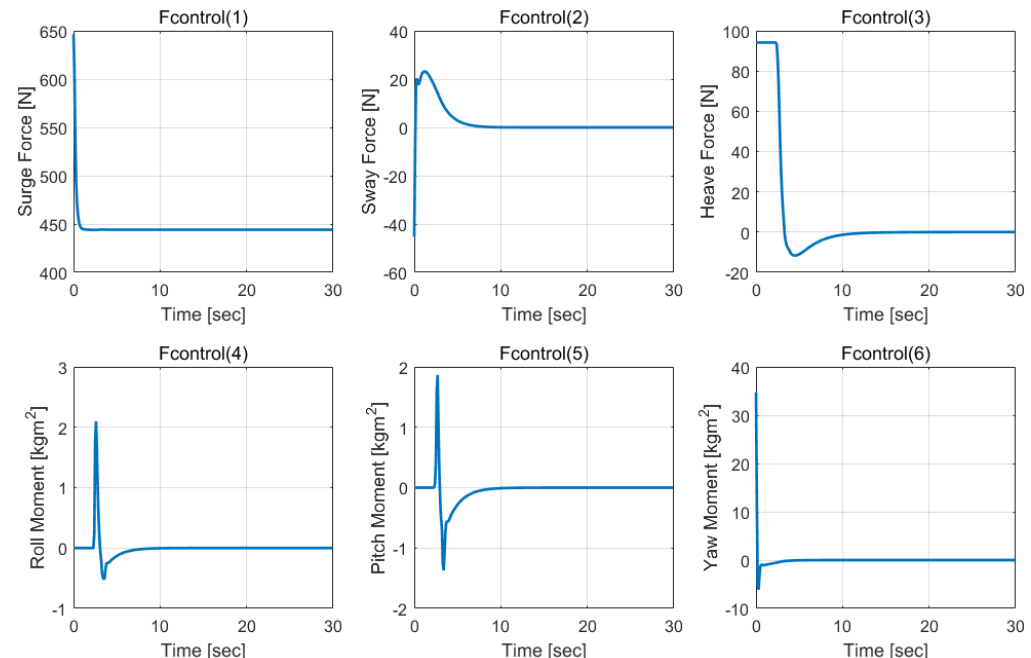
Figure 7. Calculated control forces in the maximum speed